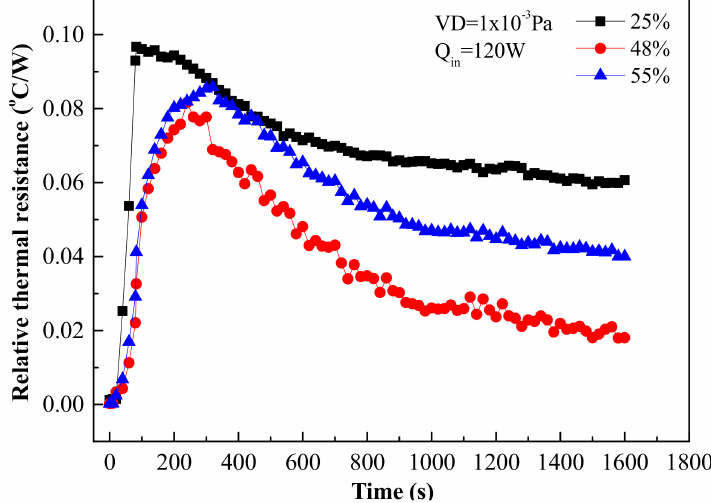
Figure 13. The relative thermal resistance on Z-axis of PGHP changing with heating time under different liquid filling